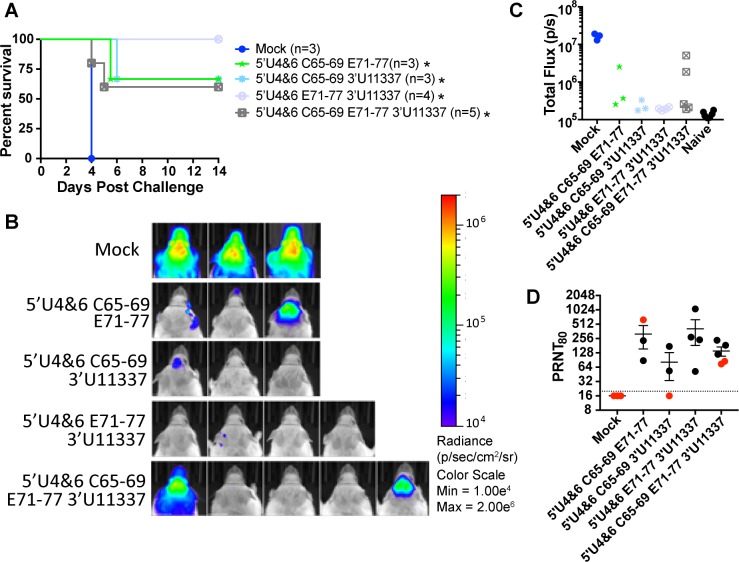
LAVs protect against a high dose EEEV aerosol challenge.Three to five CD-1 mice were challenged at D22 post primary infection with a > 1000 LD50 dose of EEEV expressing nLuc (calculated dose: 512,066 pfu) A) Survival of mice following aerosol challenge. Number of mice challenged is indicated in parentheses. * P<0.5, Log-Rank Test compared to mock unvaccinated mice B) IVIS images of LAV mice collected on day 4 post challenge. C) Quantification of IVIS images represented as total flux (p/s). Naive mice were not challenged during the experiment and used for background total flux levels. D) Serum collected on D21 prior to aerosol challenge were screened for neutralizing antibodies. Reciprocal PRNT80 values are graphed. Each dot represents a single mouse and red dots indicate mice that succumbed to the aerosol challenge. The dotted line indicates limit of detection.